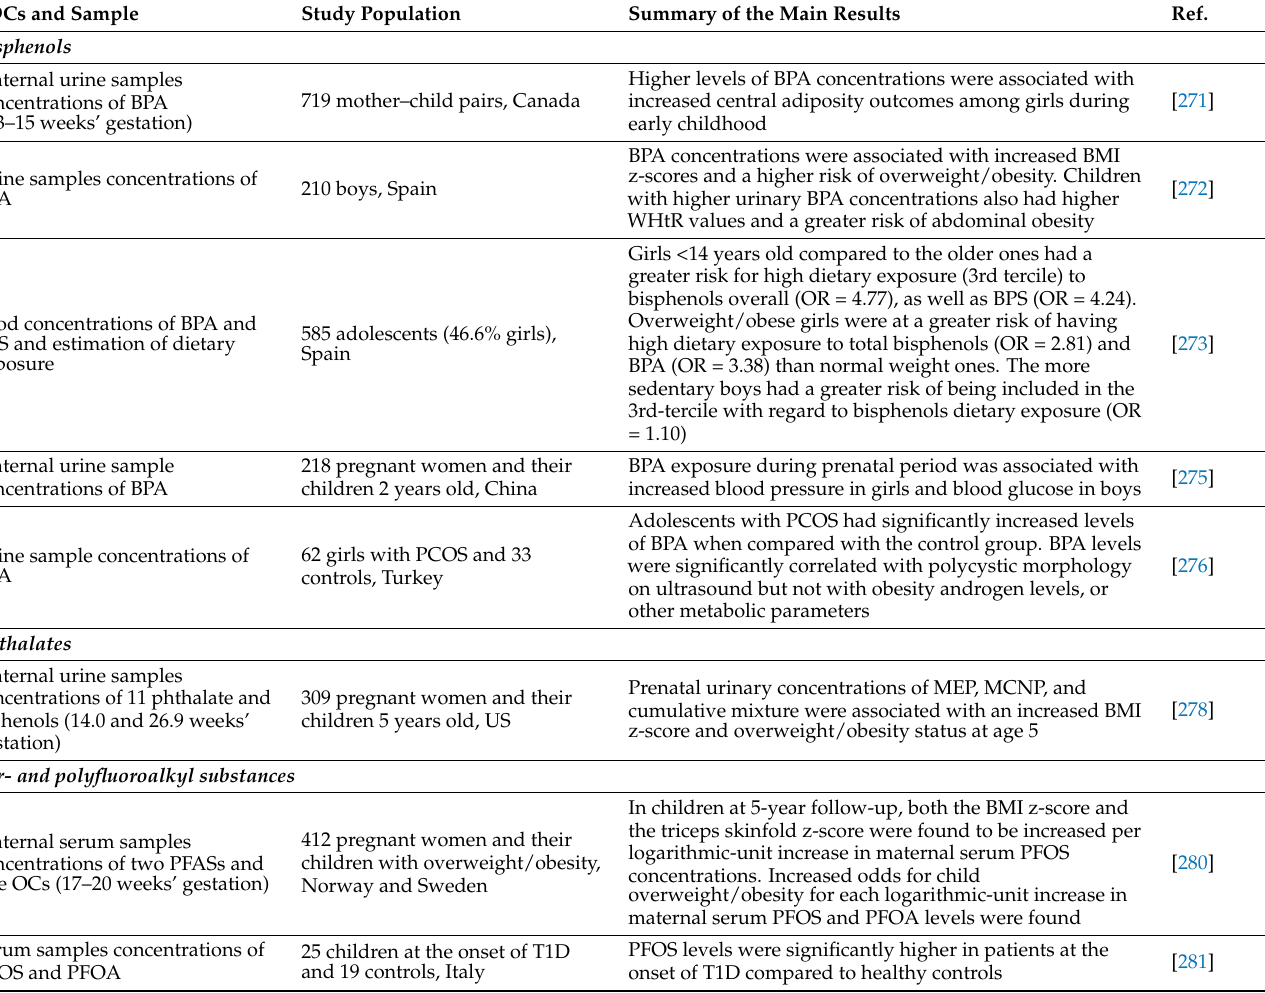
Table 8. Epidemiological data from some studies on metabolic